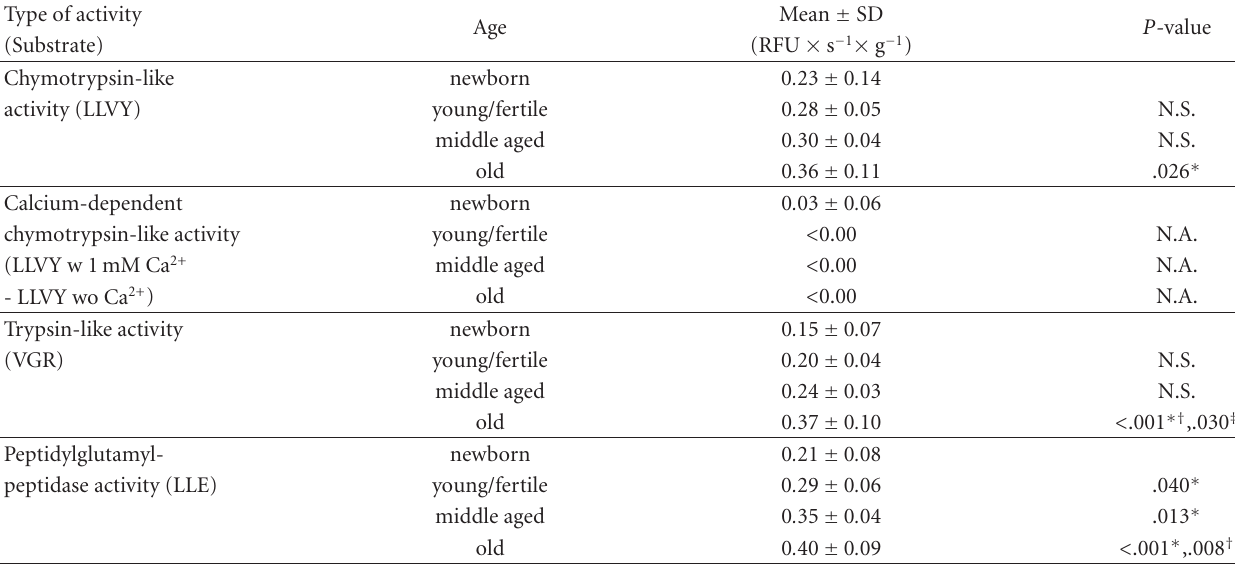
Table 3: Proteasome activity in rat